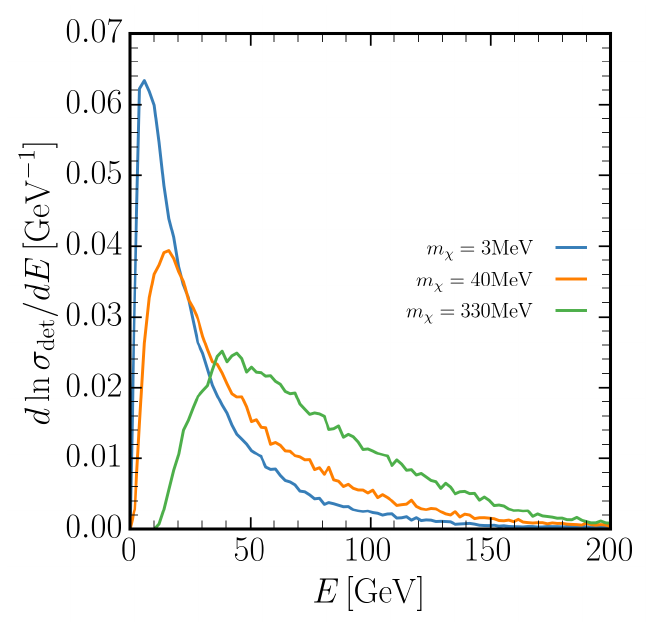
Figure 2: The differential energy distribution of dark states entering the BEBC detec-